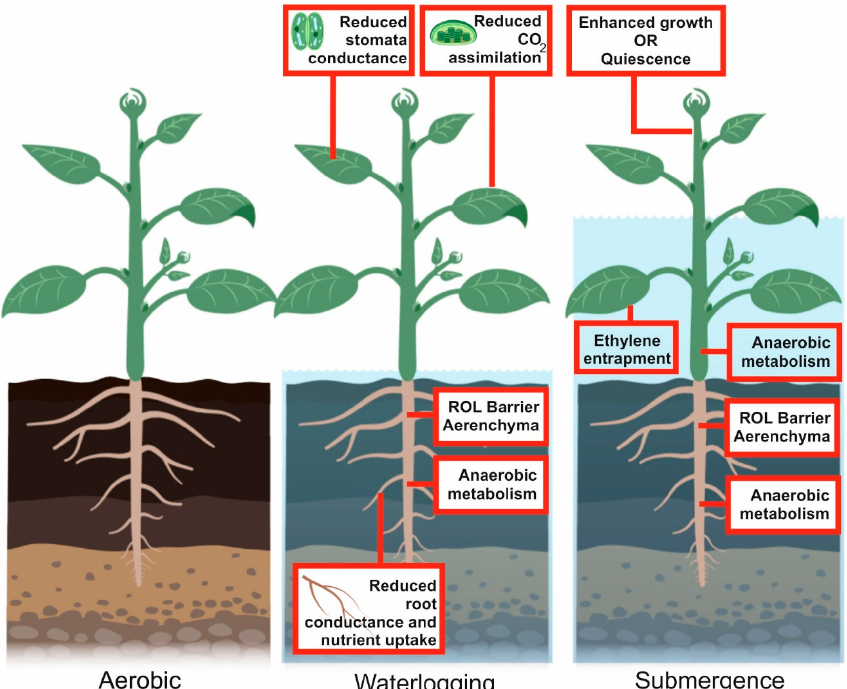
Figure 2. Environmental hypoxia is generated by soil waterlogging or by plant submergence. An excess of water in the soil reduces aerobic respiration, which is replaced by anaerobic metabolism. The uptake of nutrients is reduced. A radial oxygen loss (ROL) barrier and aerenchyma eventually develops in the root system to provide oxygen to the submerged roots. The aerial part of the plant, although not submerged, is also a ff ected by waterlogging, with reduced stomata conductance and CO 2 assimilation. Complete or partial plant submergence may trigger quiescence or escape strategies, characterized by reduced or enhanced elongation, respectively. Ethylene entrapment in the submerged plant plays an important role in defining the overall plant response to submergence. Aerenchyma develops and the metabolism is mostly anaerobic, with the exception of tissues and organs that receive su ffi cient oxygen through the aerenchyma. This figure was created using BioRender [17]. Table 1. Traits a ff ected by waterlogging and submergence in